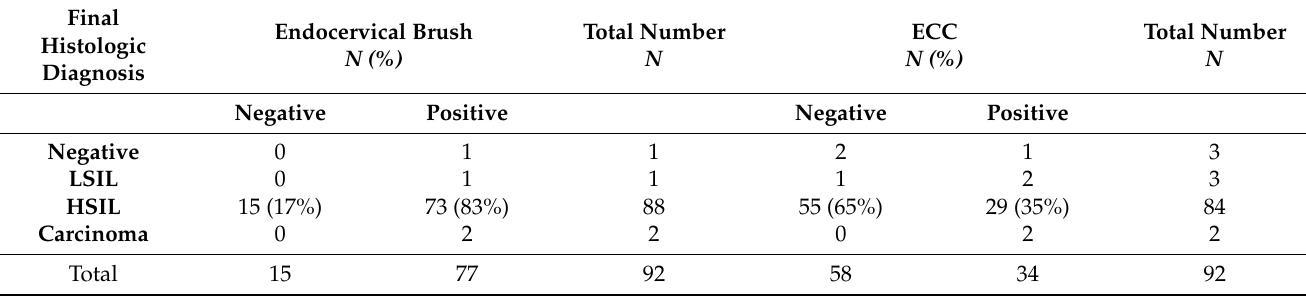
Table 4. Endocervical brush and endocervical curettage findings compared with final histologic diagnosis. (Abbreviations: ECC endocervical